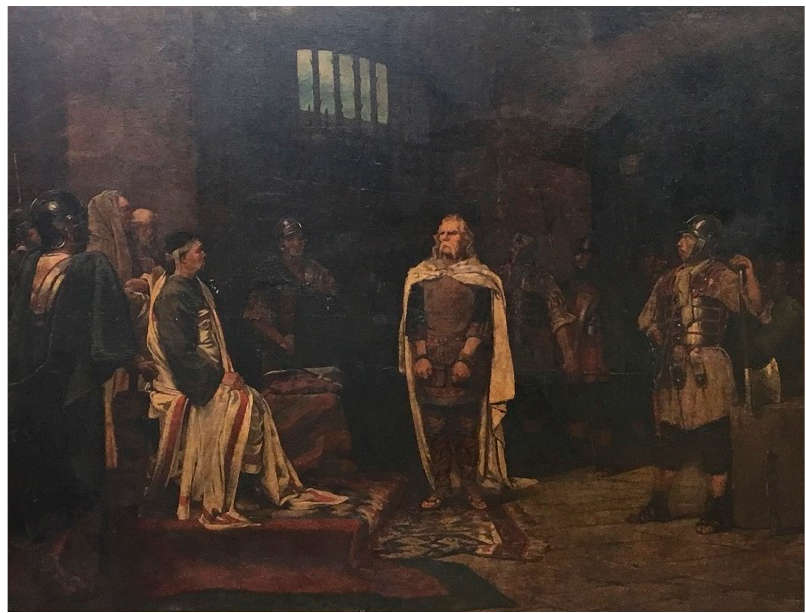
Figure 2. Firmino Monteiro, “ Vercingetorix diante de Júlio de Cesar ”, 1855–1888, dimensions (211 cm × 161 cm), National Museum of Fine Arts/collection, Rio de Janeiro.